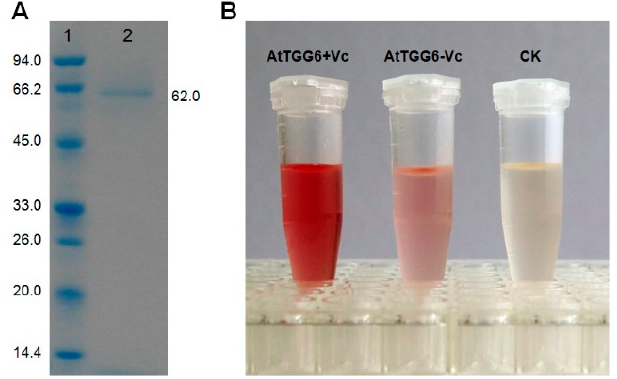
Figure 2. Myrosinase activity of recombinant AtTGG6 from Arabidopsis ecotype Tsu-1. ( A ) Sodium dodecyl sulfate-polyacrylamide gel electrophoresis (SDS-PAGE) of recombinant protein overexpressed in Pichia pastoris GS115; Lane 1 , molecular weight marker, the mass of each band in kilodalton (kD) is shown to the left; Lane 2 , purified recombinant AtTGG6; ( B ) Myrosinase activity of purified AtTGG6 as visualized using a glucose test reagent; AtTGG6 + Vc, AtTGG6 (50 ng) plus 0.8 mM ascorbic acid (Vc); AtTGG6 − Vc, AtTGG6 (50 ng) only, Vc not added; CK, AtTGG6 (50 ng) disabled by heating at 95 °C for 5 min before use.